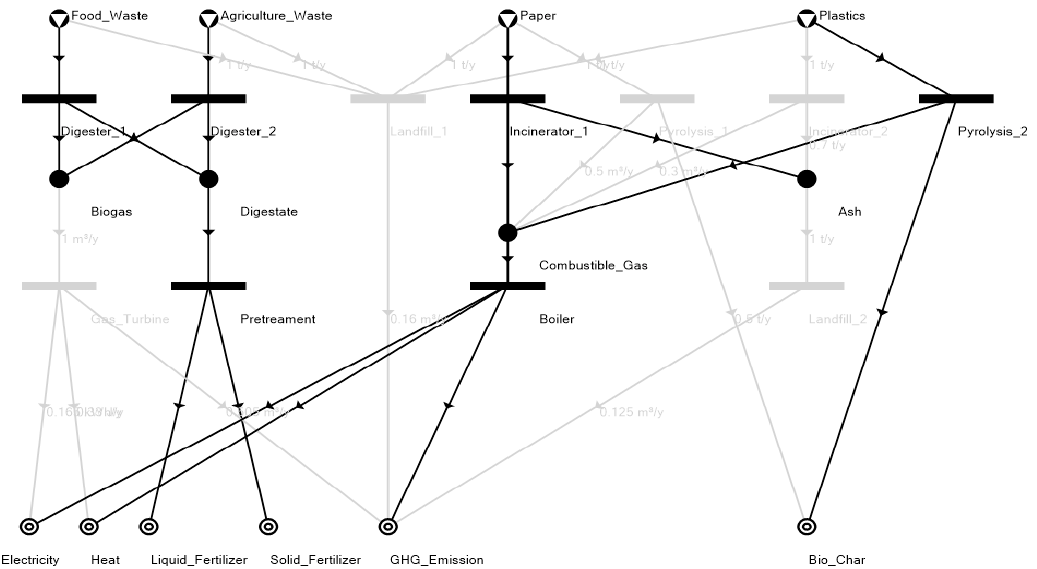
Figure 8. Feasible structure with the maximum economic performance.